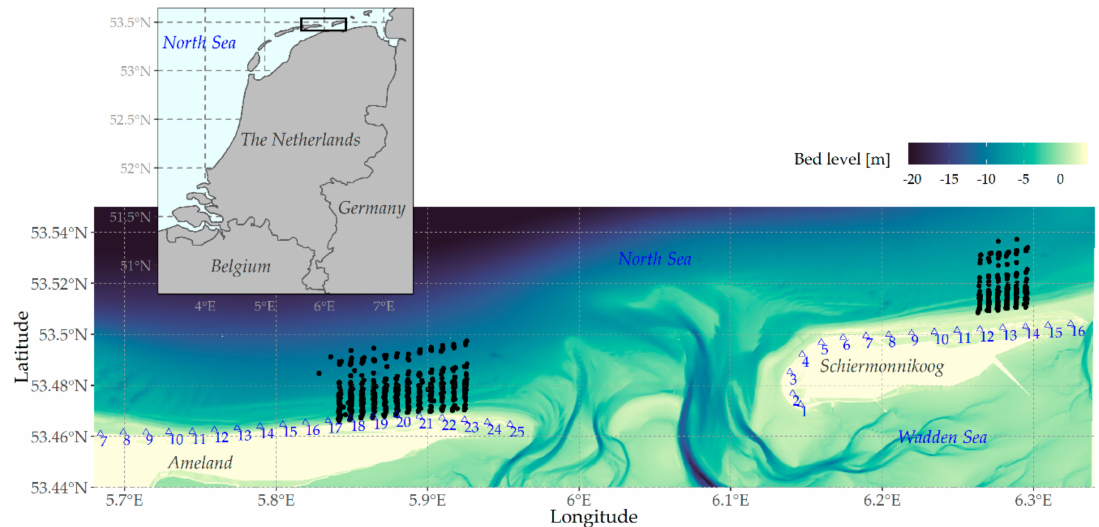
Figure 1. Sample locations (black dots) in the nearshore of Ameland and Schiermonnikoog for annually repeated surveys in 2010–2014. The bed level is expressed relative to NAP, the Dutch Ordnance level that approximately corresponds to MSL. Blue triangles are the beach posts per